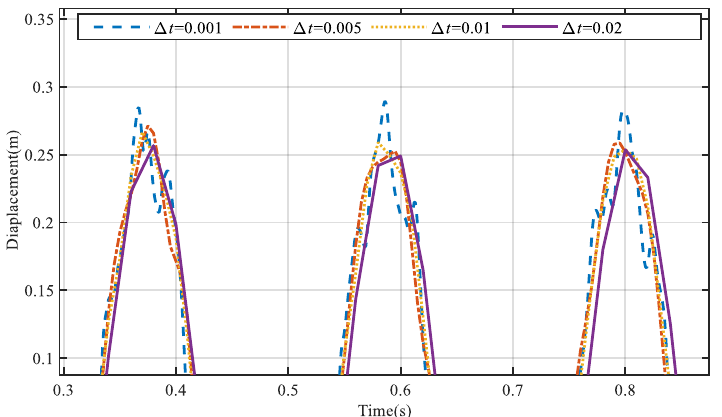
Figure 20. Displacement responses of Point A with different time steps.